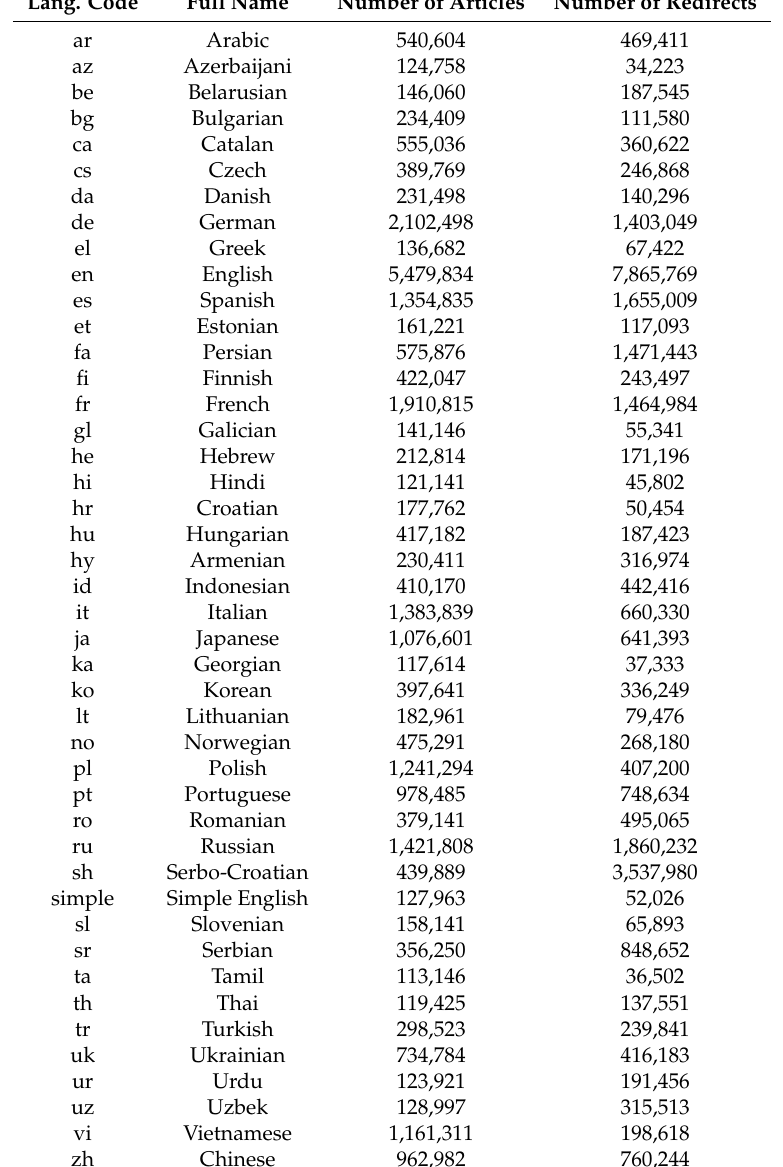
Table 2. Number of articles and redirects in considered language versions of Wikipedia. Lang.